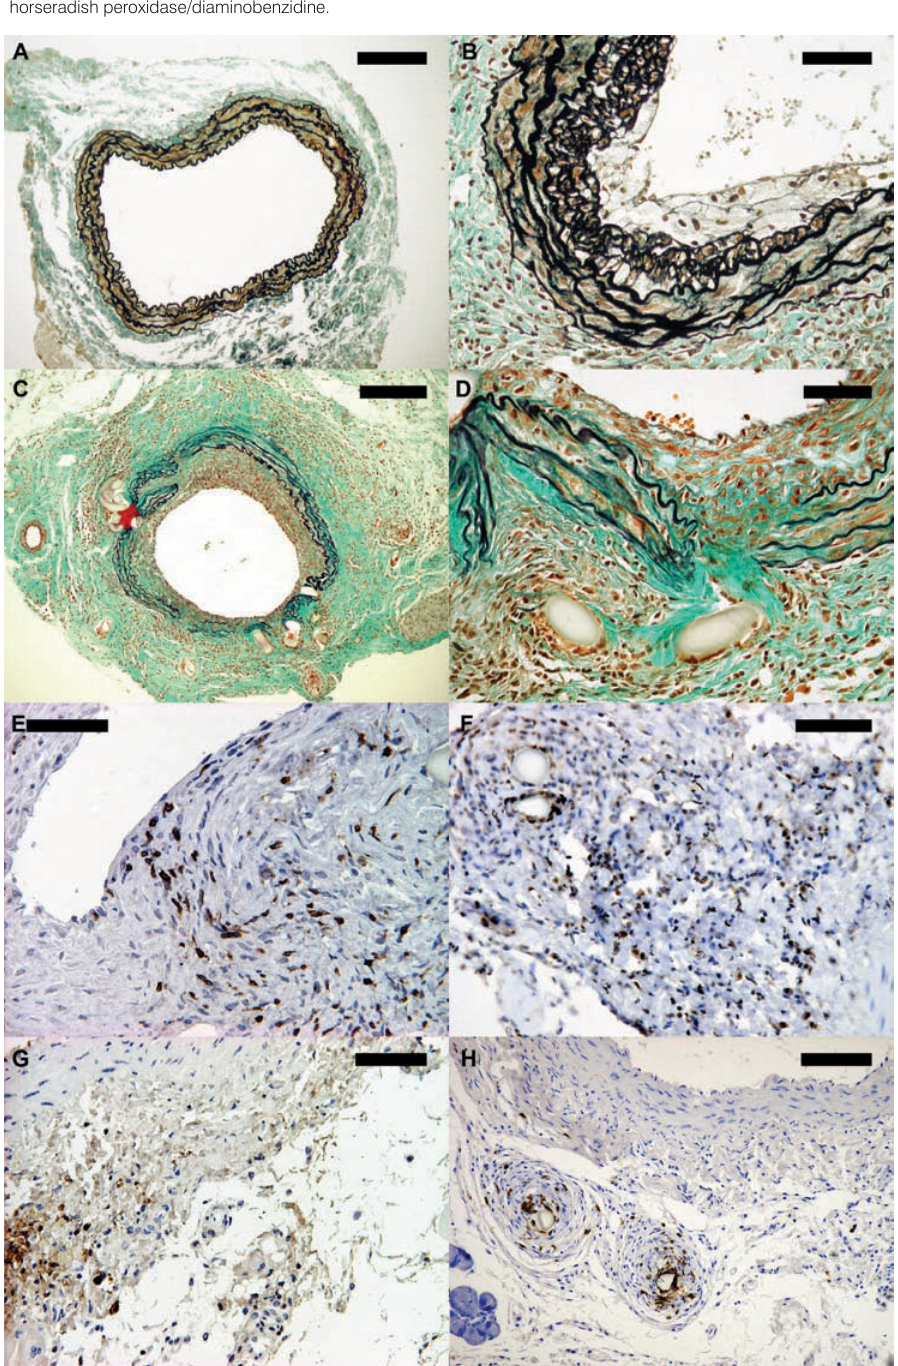
Figure 3. Histology of aorta grafts and adjacent host aorta segments. (A) Non-transplanted lesion-free abdominal aorta of a wild-type mouse (Group 3). Scale bar 100 m m. (B) Foam cells in the intima of an ApoE-/- mouse, non-transplanted segment (Group 1). Scale bar 50 m m. (C) Aorta of a wild-typeto wild-typetransplantation case (Group 3) with nearly concentric intimal thickening. Scale bar 200 mm. (D) Same, detail of elastinolysis and inflammatory cells surrounding the stitch. Scale bar 50 m m. A-D were stained with green trichrome and Verhoeff’s hematoxylin. (E) T-lymphocytes infiltrating the tunica media of a transplanted aorta segment of a wild-type mouse (Group 3), immunohistochemical detection of CD3. Scale bar 50 m m. (F) B-lymphocytes surrounding the stitch in the tunica adventitia of a transplanted aorta segment of an ApoE-/- mouse (Group 2), immunohistochemical detection of CD20. Scale bar 70 mm. (G) Macrophages in the tunica adventitia of the same sample as in F, immunohistochemical detection of MCA 874G. Scale bar 70 m m. (H) Neutrophilic leukocytes encircle a stitch in the tunica adventitia of a transplanted segment of an ApoE-/- mouse (Group 1), immunohistochemical detection using an anti-mouse neutrophils antibody. Scale bar 100 mm. (E-H) Visualisation of the immunoreaction horseradish